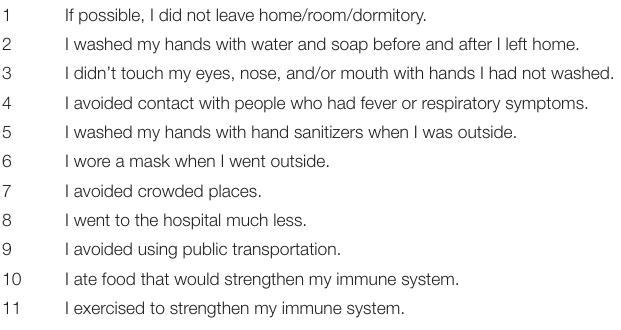
TABLE 2 | Preventive measures. TABLE 3 | Main